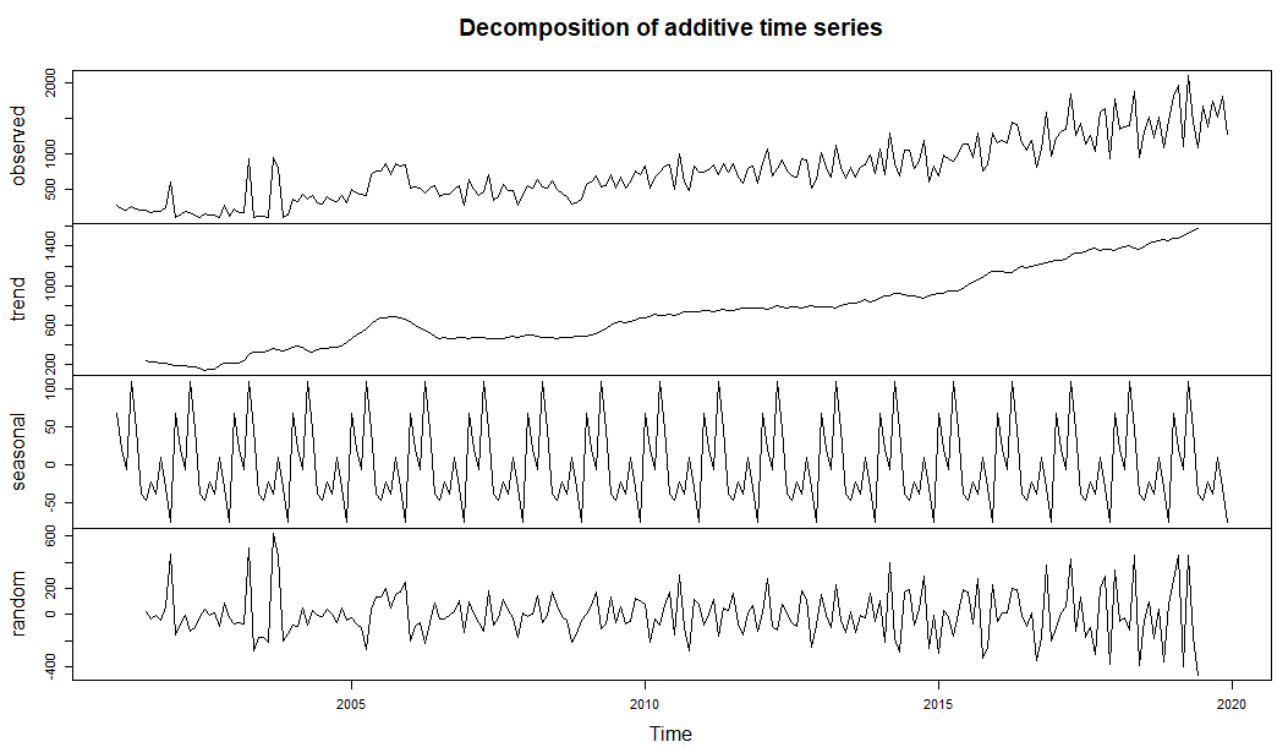
Figure 9. Decomposition of the “Palmet” time series. Note: The numbers on the y-axis represent the absolute number multiplied by 1000.